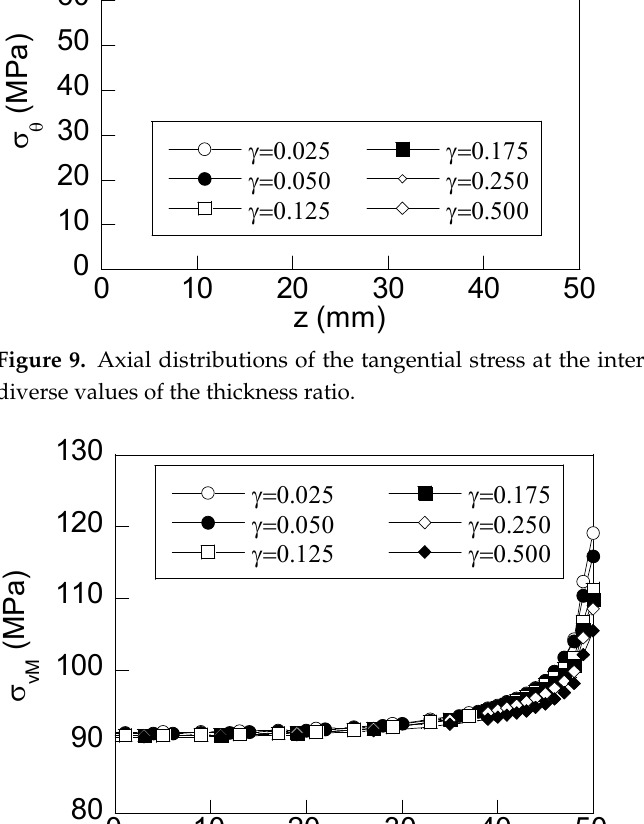
Figure 10. Radial distributions of the von Mises stress at the interface contact of the ring/shaft for diverse values of the thickness ratio.